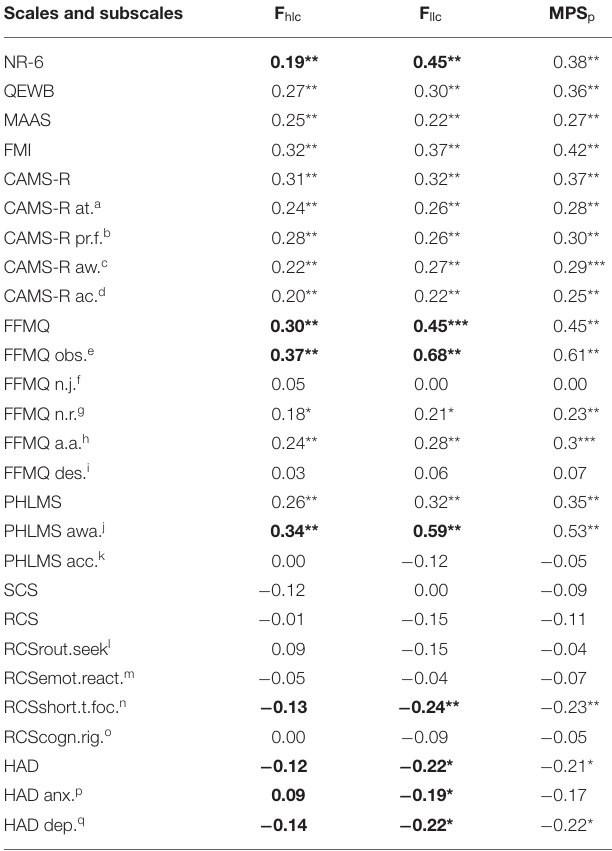
TABLE 8 | Concurrent